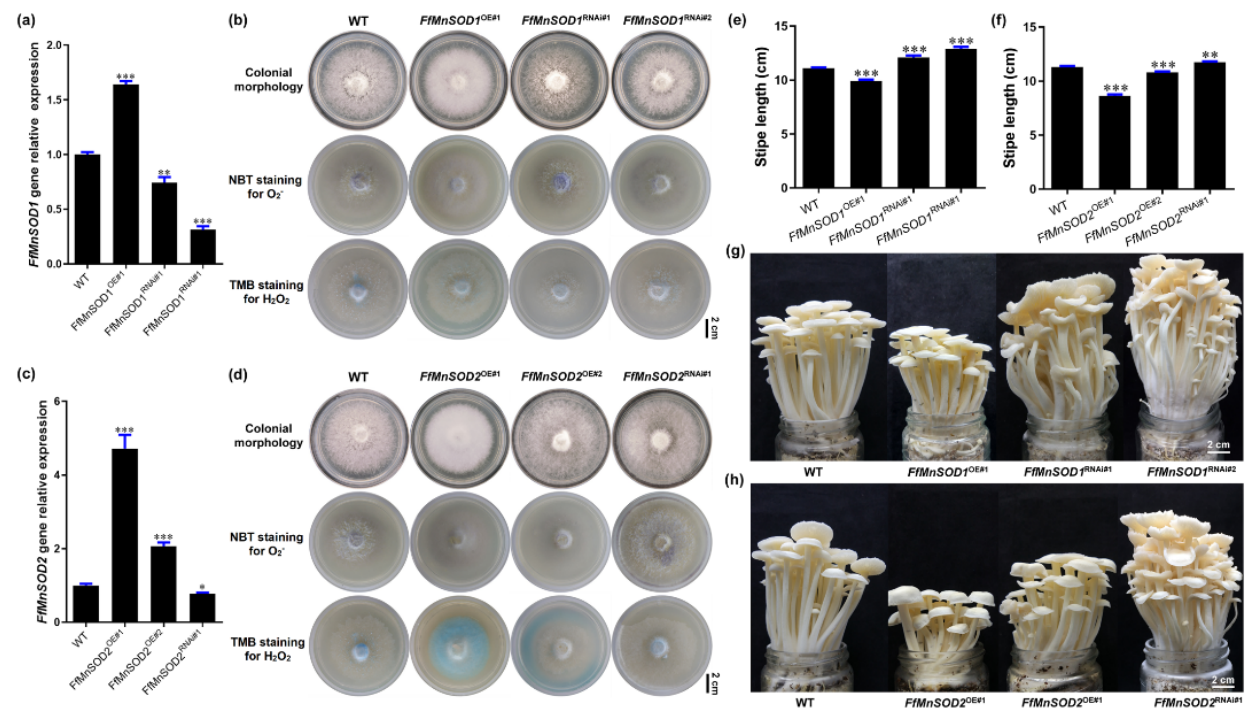
Figure 6. Gene expression, ROS detection, and stipe elongation phenotype in the wild type (WT) and FfMnSOD1 and FfMnSOD2 overexpression and RNAi lines. ( a ) The relative gene expression in the WT, FfMnSOD1 overexpression lines, and RNAi lines. ( b ) Colony morphology, and histochemical staining with NBT for O 2 − (purple) and TMB for H 2 O 2 (blue) detection in WT, FfMnSOD1 overexpression lines, and RNAi lines (Bar = 2 cm). ( c ). The relative gene expression in the WT, FfMnSOD2 overexpression lines, and RNAi lines. ( d ) Colony morphology, and histochemical staining with NBT for O 2 − (purple) and TMB for H 2 O 2 (blue) detection in the WT, FfMnSOD2 overexpression lines, and RNAi lines (Bar = 2 cm). ( e ) The total stipe length at the maturation stage in WT, FfMnSOD1 overexpression lines, and RNAi lines ( n = 35). ( f ) The total stipe length at the maturation stage in the WT, FfMnSOD2 overexpression lines, and RNAi lines ( n = 35). ( g ) The phenotype of fruiting bodies of the WT, FfMnSOD1 overexpression lines, and RNAi lines at the maturation stage (Bar = 2 cm). ( h ) The phenotype of fruiting bodies of the WT, FfMnSOD2 overexpression lines, and RNAi lines at the maturation stage (Bar = 2 cm). The significance levels were calculated by paired t-test compared with the WT sample, * p < 0.05, ** p < 0.01, *** p <